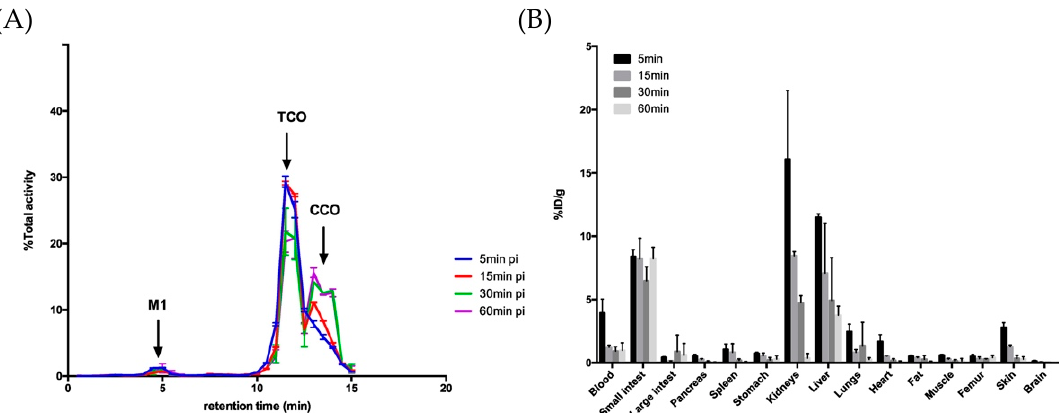
Figure 4. ( A ) In vivo plasma metabolites and ( B ) biodistribution of [ 18 F]F-MICA-205 in healthy Balb/C mice at 1 h post injection [86].